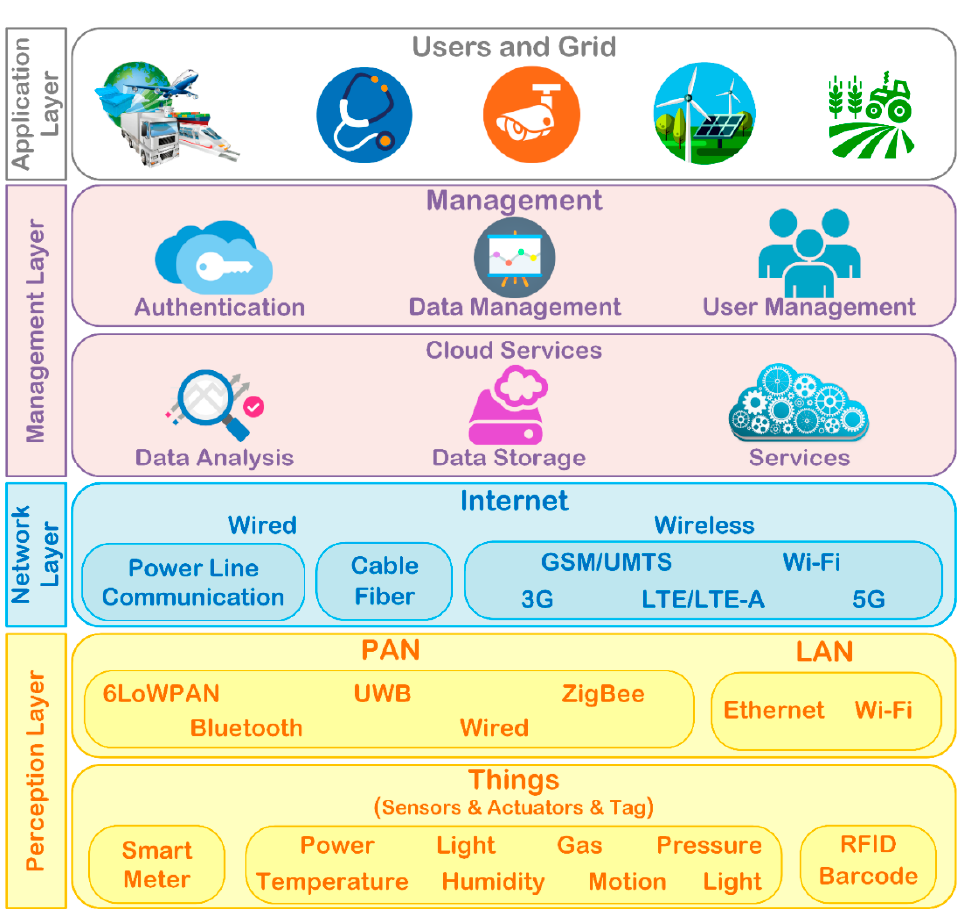
Figure 3. Layers and several applications of IoT for smart environments.